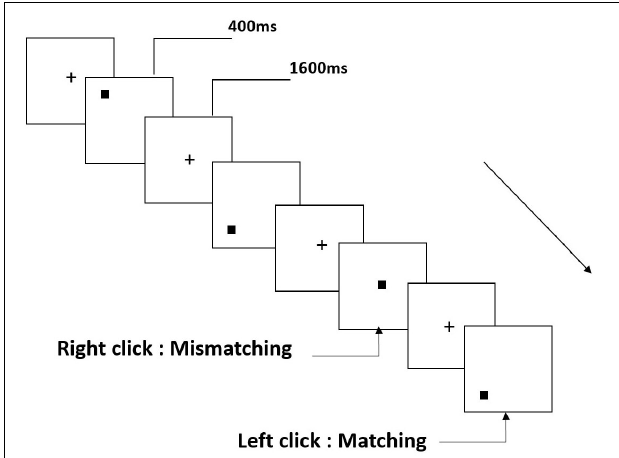
FIGURE 1 | Schematic diagram of spatial working memory